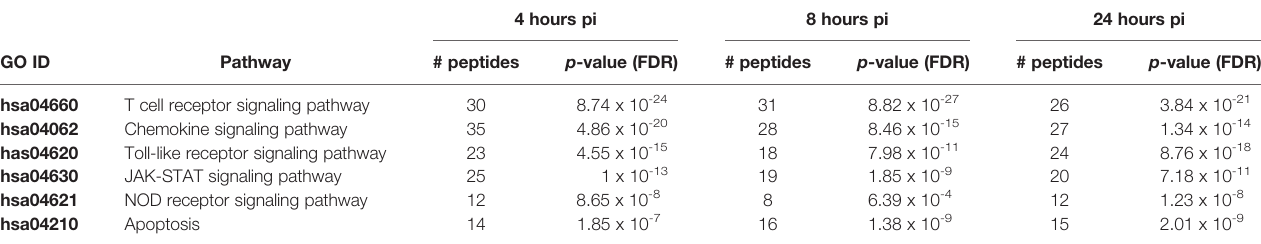
TABLE 3 | Kegg pathways generated by Search Tool for the Retrieval of Interacting Genes/Proteins (STRING) with consistent altered phosphorylation across all time